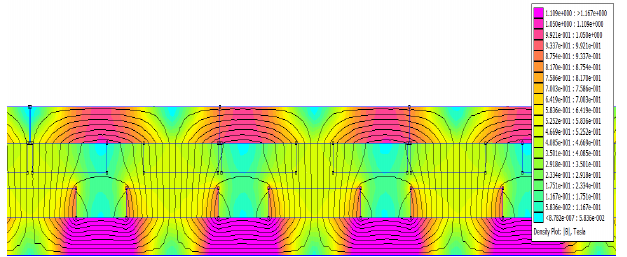
Fig. 6. Field distribution in the machine with replaceable coil section.